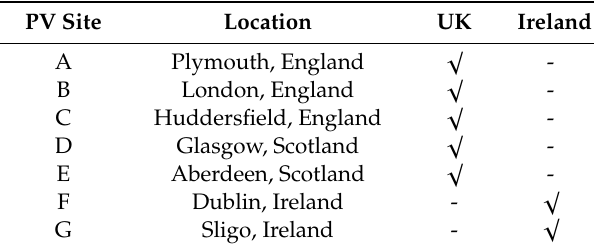
Figure 1. Examined photovoltaic (PV) systems’ configuration and geographical representation: ( a ) geographical distribution of the examined PV installations in the United Kingdom including the average irradiance (G) and temperature (T) over the last 30 years; ( b ) real picture of the examined PV system installed at Huddersfield site—PV site C; ( c ) and PV sites’ configuration, which comprised two parallel PV strings each consisting of nine series-connected PV modules. Table 1. Distribution of the Examined PV Systems.